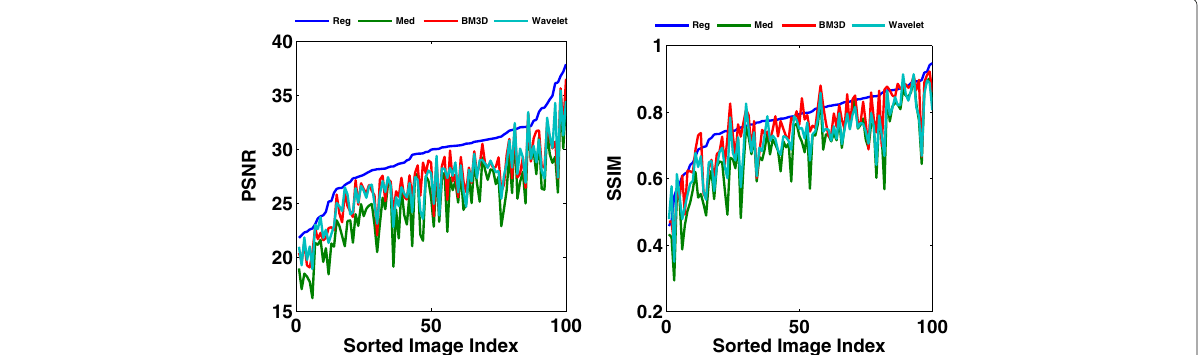
Fig. 12 One-hundred sample images denoised using our L 2 regression filter, median filter, BM3D, and wavelet filters with Poisson